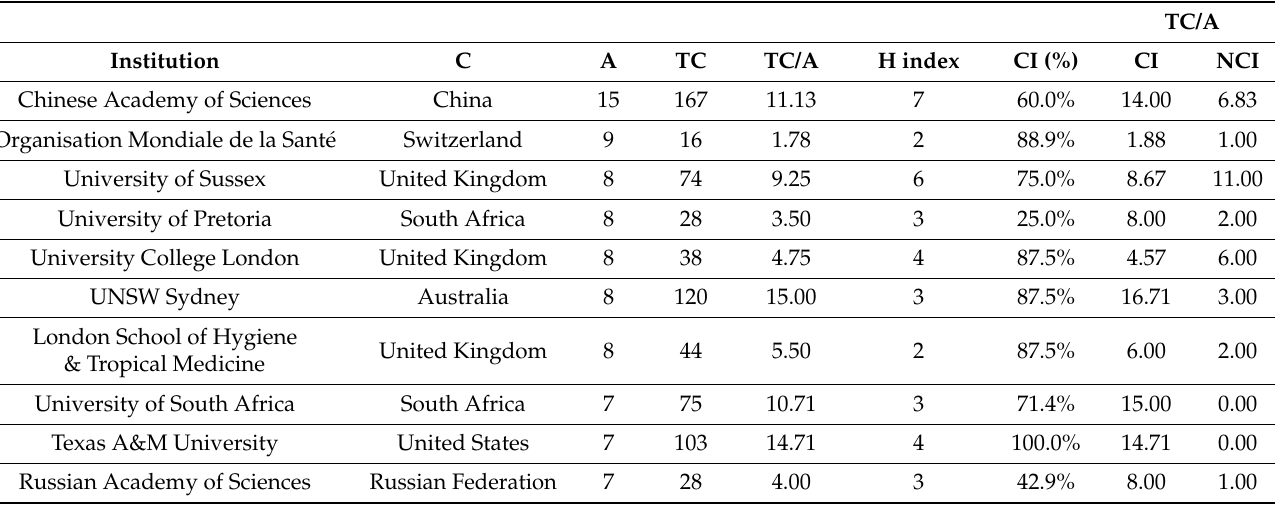
Table 5. The ten most productive